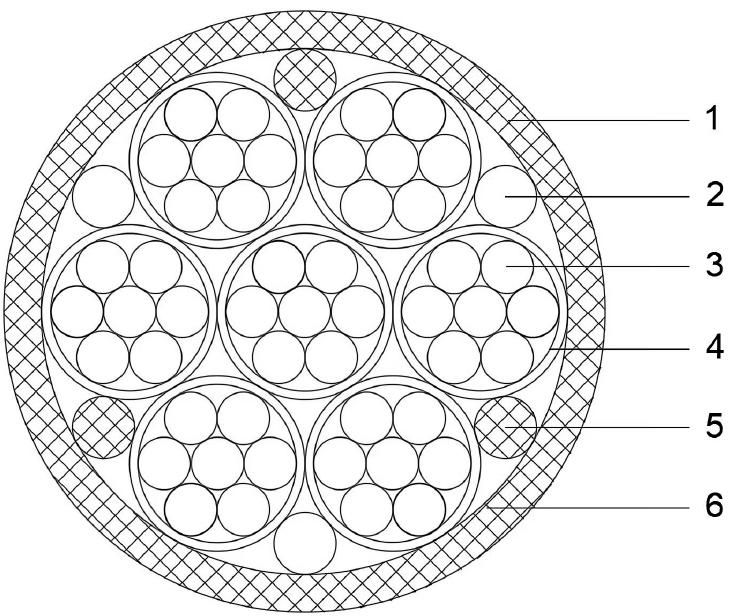
Figure 4. Sectional view of finished FAST cables. 1: Outer HDPE; 2: galvanized steel wire; 3: epoxy-coated steel strand; 4: inner HDPE; 5: stuffing rope; 6: high-strength polyester